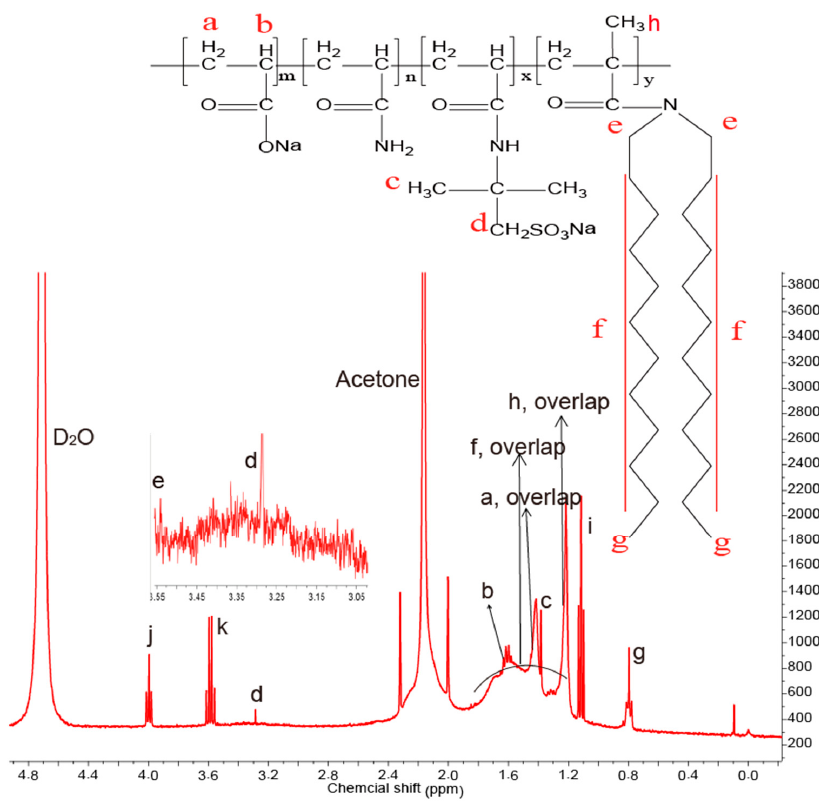
Figure 2. The 1 H NMR (400 MHz, D 2 O) spectrum of DiPHAM.